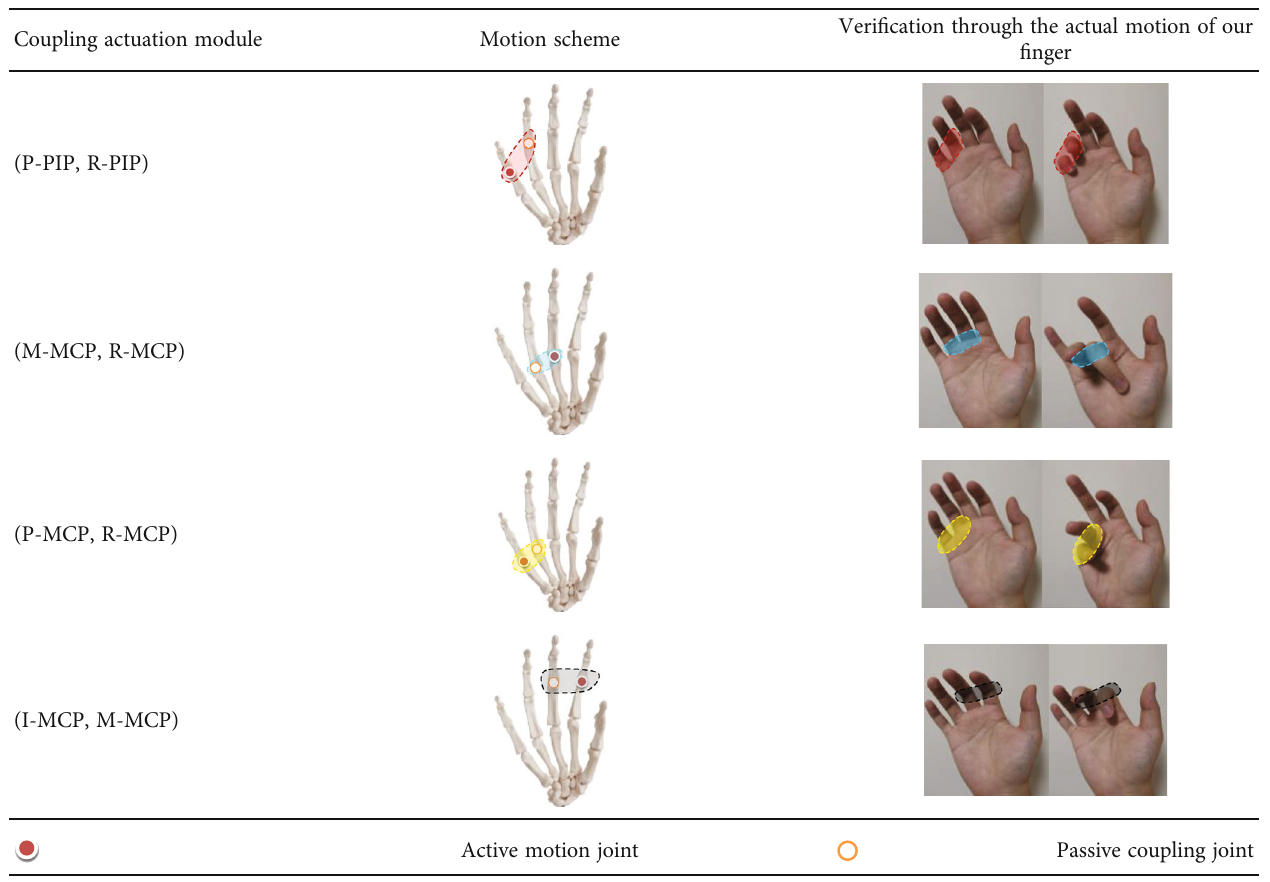
Table 5: Veri fi cation of coupling actuation con fi